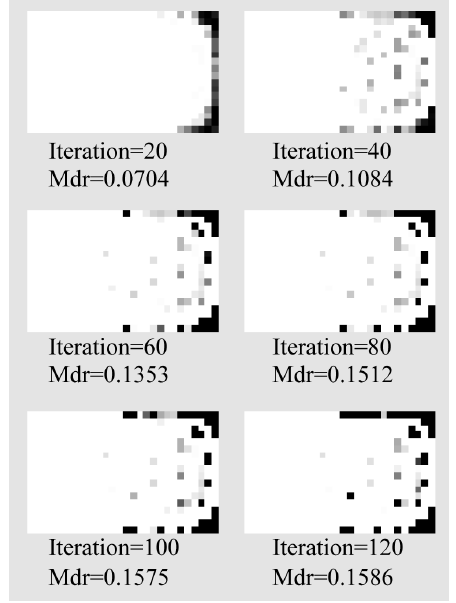
Fig. 5. Optimal distribution of damping material at different iteration numbers, vf = 0.2.